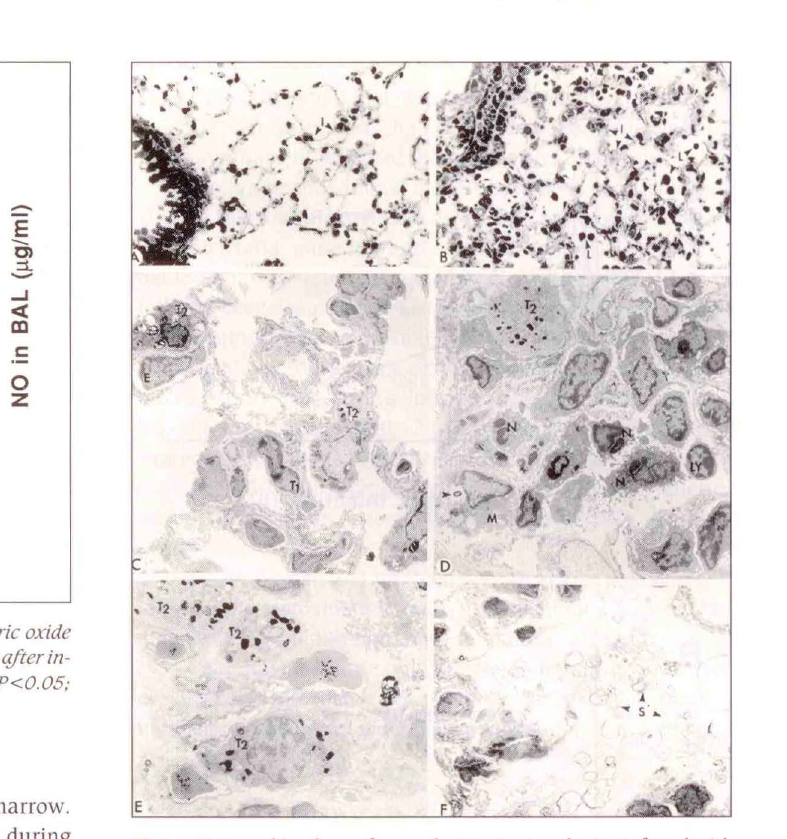
Figure 7) Lung histology if normal mice (A,C) and mice ilifected with 10 7 Streptococcus pneumoniae cells and killed 72 h later (B,O,E,F). Interstitial tissues(!) in alveolar areas (A,B) wereenla,ged in irifected mice (B), and leuko<ytes (L) can be seen in alveoli. Tissue injury char acterized the irifeccious and ir!flammato,y processes (0). Macrophages (M) containing ingested bacteria (arrowhead) were seen. as well as